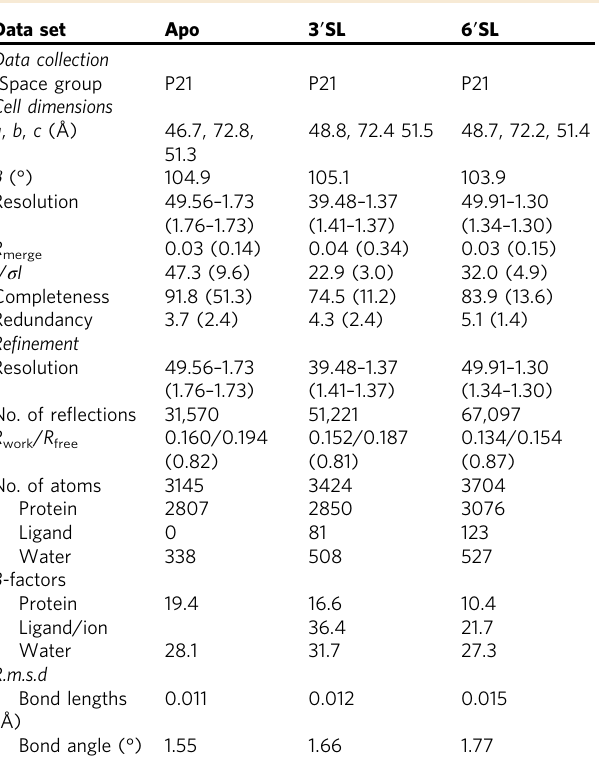
Table 1 Data collection and re fi nement statistics